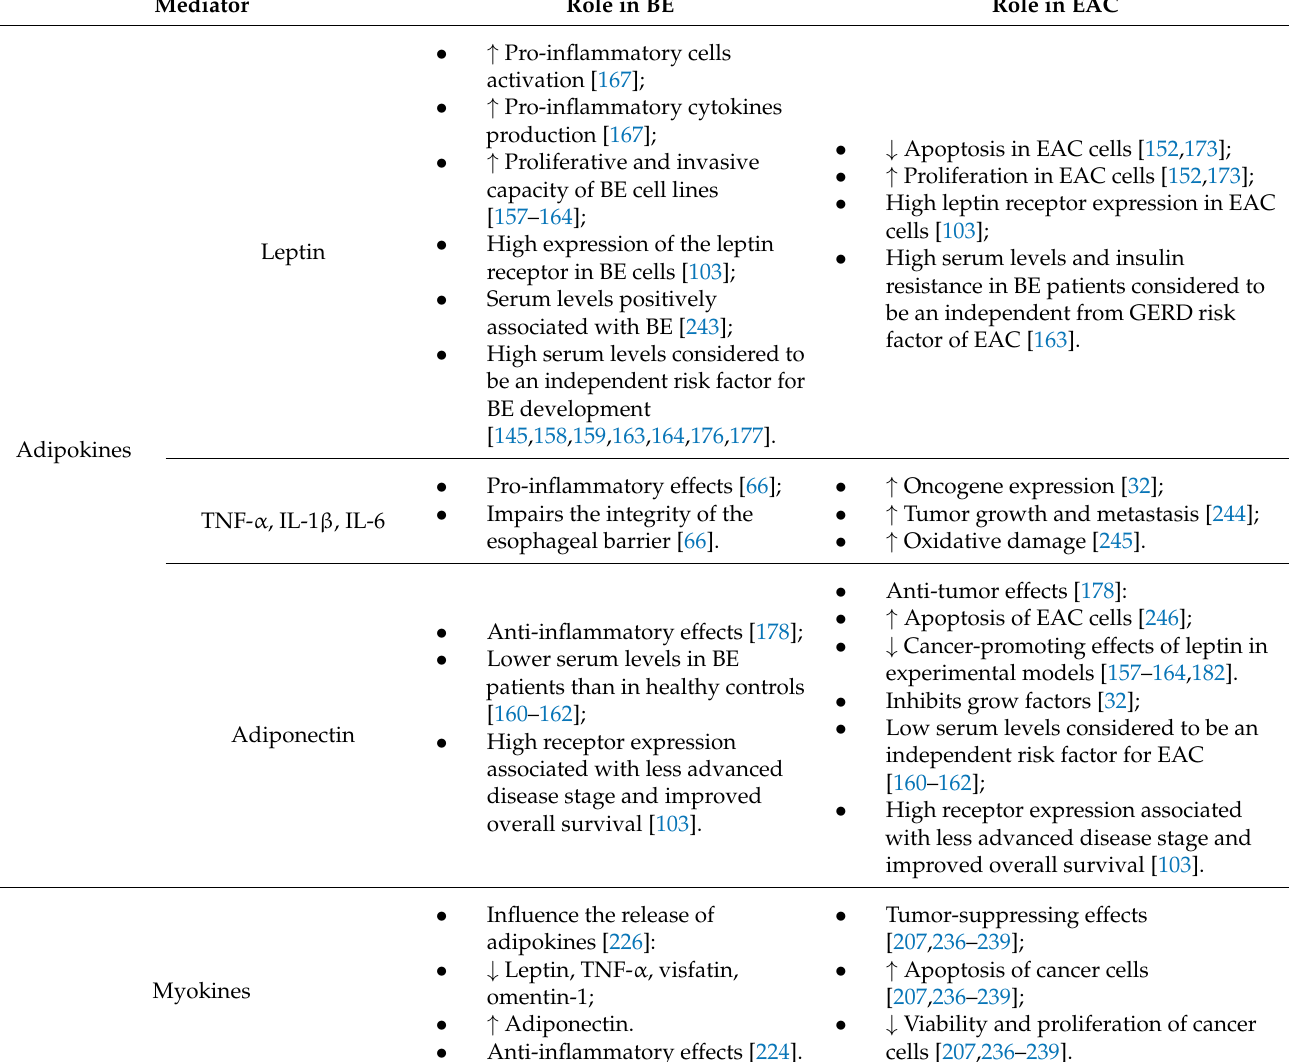
Table 1. The role of mediators secreted by adipose tissue (adipokines) and muscle tissue (myokines) in the development of Barrett’s esophagus (BE) and esophageal adenocarcinoma